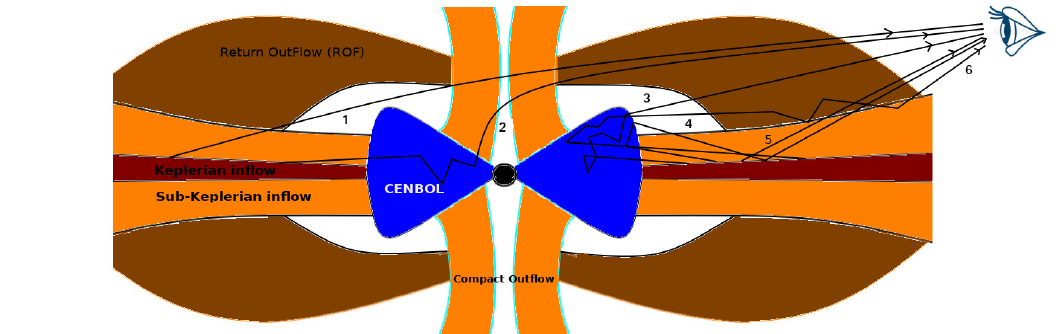
Figure 2. Cartoon diagram of two-component advective flow (TCAF) in the presence of Return OutFlow (ROF) is shown. Pseudo-colors represent approximated temperature profile within the disk. Six emergent photon types are shown in the cartoon. Photon type 1 denotes the soft photons which have suffered gravitational bending but are not intercepted by the CENBOL. Photon 2 represents the hard photons which are scattered in the CENBOL and undergone gravitational bending to reach the distant observer at high inclination angle. Photon type 3 is scattered in the CENBOL without suffering bending reaching the observer. The fourth category of photons is the hard photons, which are reflected by the Keplerian disk. Number five represents the soft photons that arrive the detector plane without scattering. Photon type (6) denotes the photons that are scattered in the Compton cloud and again downscattered in the ROF region while reaching the